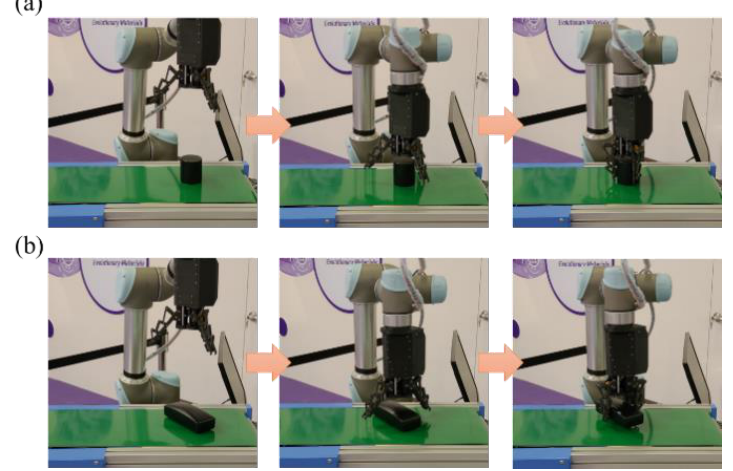
Figure 28. Illustrative examples showing the model gripper grasping ( a ) a small cylinder, and ( b ) an eyeglass box object from the conveyor.